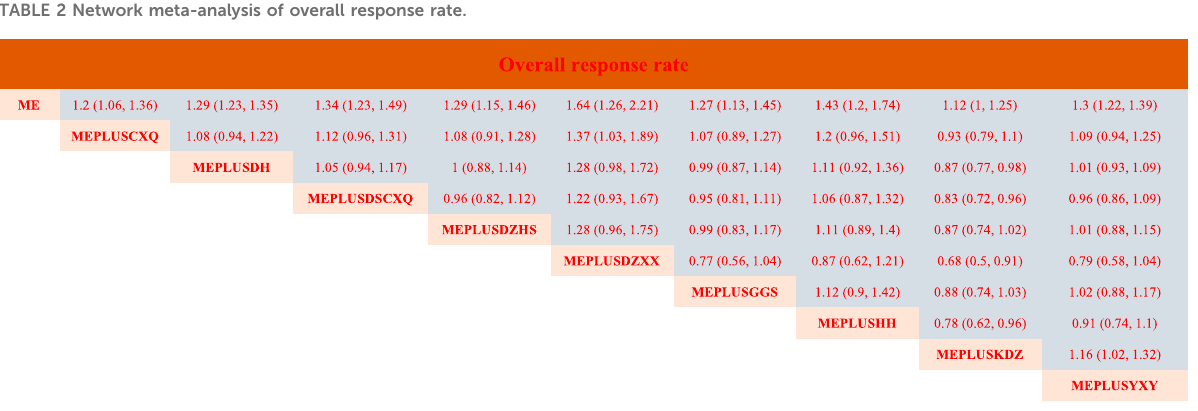
TABLE 2 Network meta-analysis of overall response